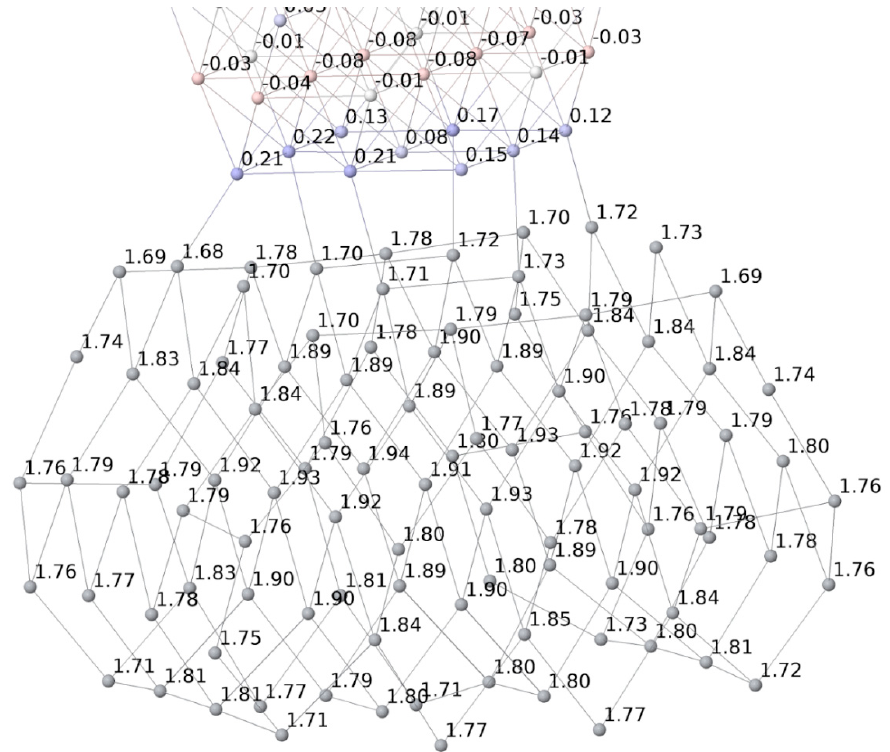
Figure 8. The (Au 55 (TiO 2 ) 97 H 8 ) +5 with only the titanium subnetwork and gold atoms with their corresponding point charges.